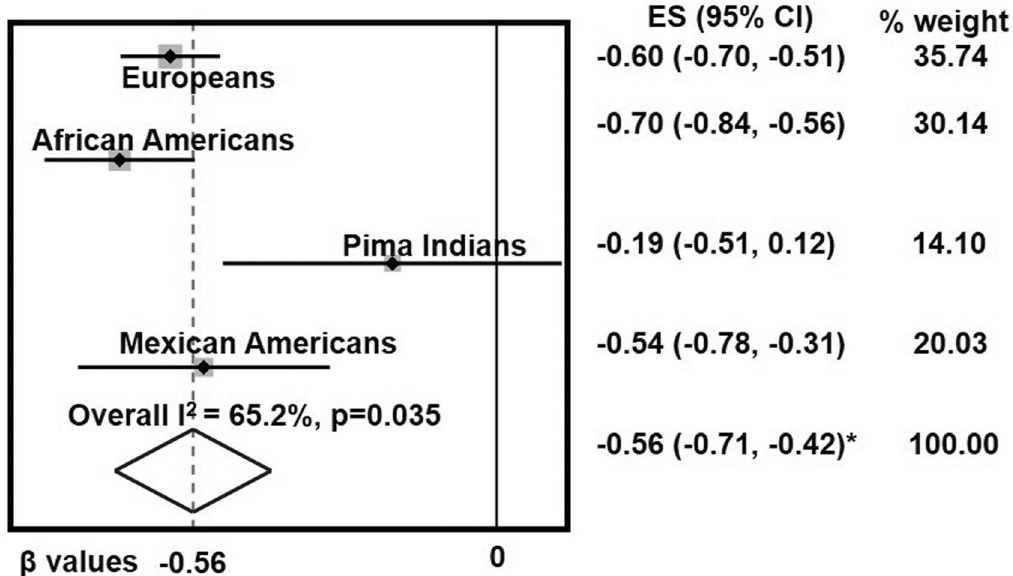
Figure 1. Global relevance of the inverse association of ADH1B expression with obesity traits. Meta-analysis, using a random effects model, was performed to evaluate the relationship between adipose ADH1B mRNA expression and BMI in populations from four ethnic groups (Europeans, African Americans, Pima Indians, and Mexican Americans) as indicated. The data show point estimates and 95% confidence intervals for BMI β-values in each ethnic group. Gray squares represent weighted contributions from each study, and the diamond represents the overall summary statistic. For each standard deviation of decreased ADH1B expression, BMI was increased by 0.56 standard deviations, *P <